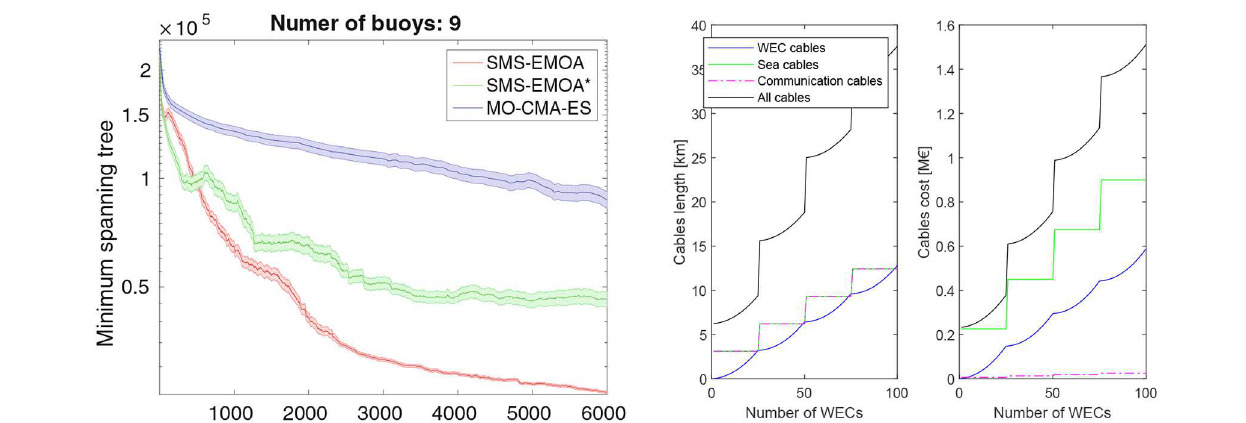
FIGURE 14 | Wave energy park optimization from the perspective of minimizing cable costs. (Left) Arbonès et al. (2016) performed both the minimization of cable length and park area and the maximization of power output in a multi-objective optimization. The figure shows the minimization of cable length, computed as a Euclidean minimum spanning tree, with three different optimization algorithms. (Right) Cable length as a function of the number of WECs and associated costs for a park of point-absorbers up to 100 WECs. The sharp increase in cable lengths and costs corresponds with the additional number of electrical substations that must be installed in the park with an increasing number of WECs ( Giassi et al.,